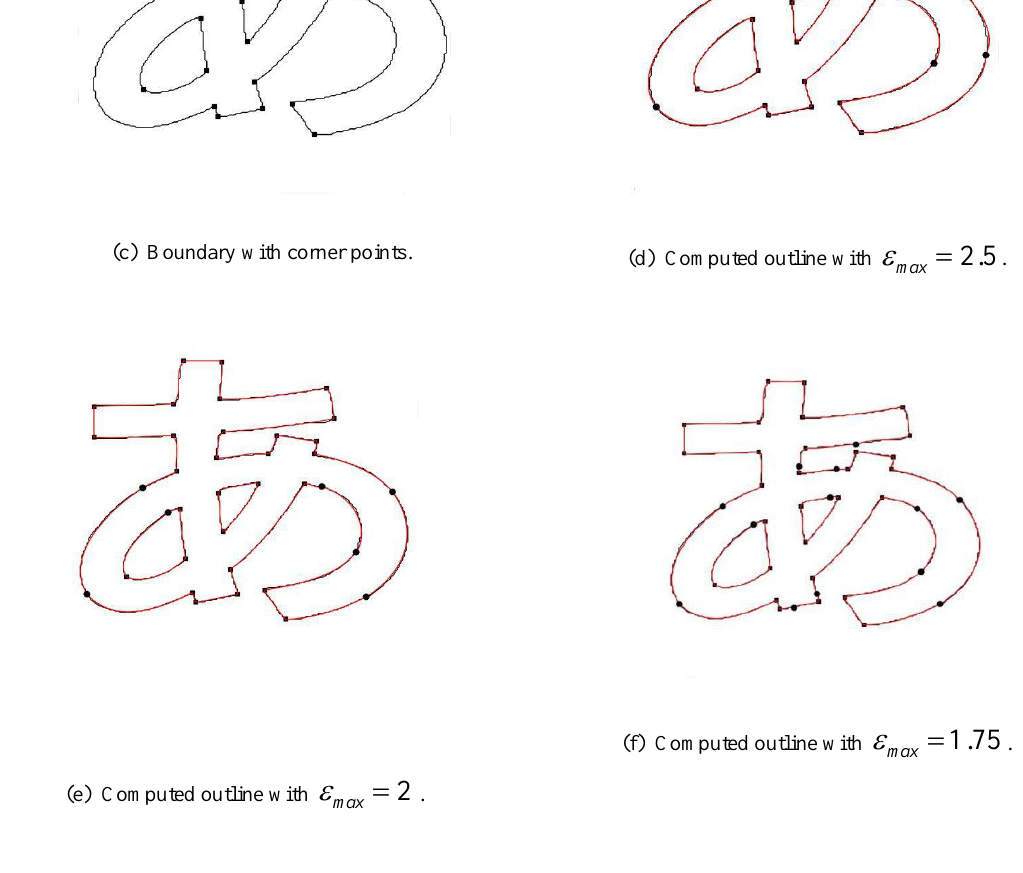
Figure 4. Captured shape of Kanji character. The black and red lines show the original and computed curves, respectively